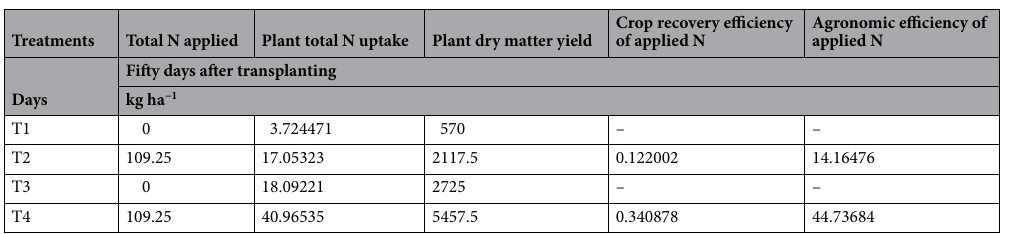
Table 18. Chicken litter biochar application and split application of urea on crop recovery and agronomic efficiency on day fifty after transplanting.